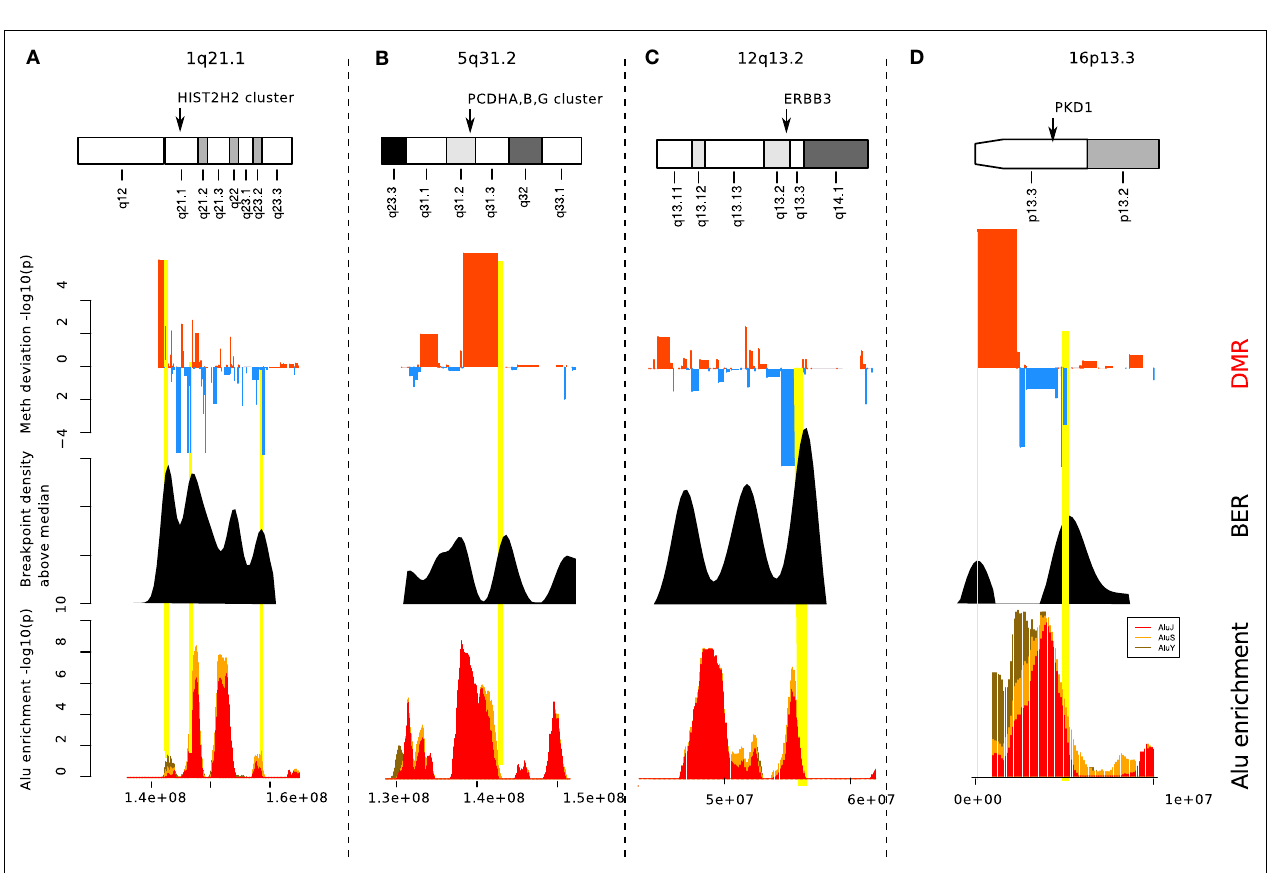
FIGURE 6 |Alu enrichment at BEDMRs. Locations of significant DMRs (top track) near breakpoint enriched regions (middle track) are compared with local Alu repeat enrichment (bottom track). About 33 of the 93 identified BEDMRs overlap with an Alu enriched region.We show here four interesting regions on 1p21.1 (A) , 5q31.2-3 (B) , 8q24.3 (C) , and 16p13.3 (D)